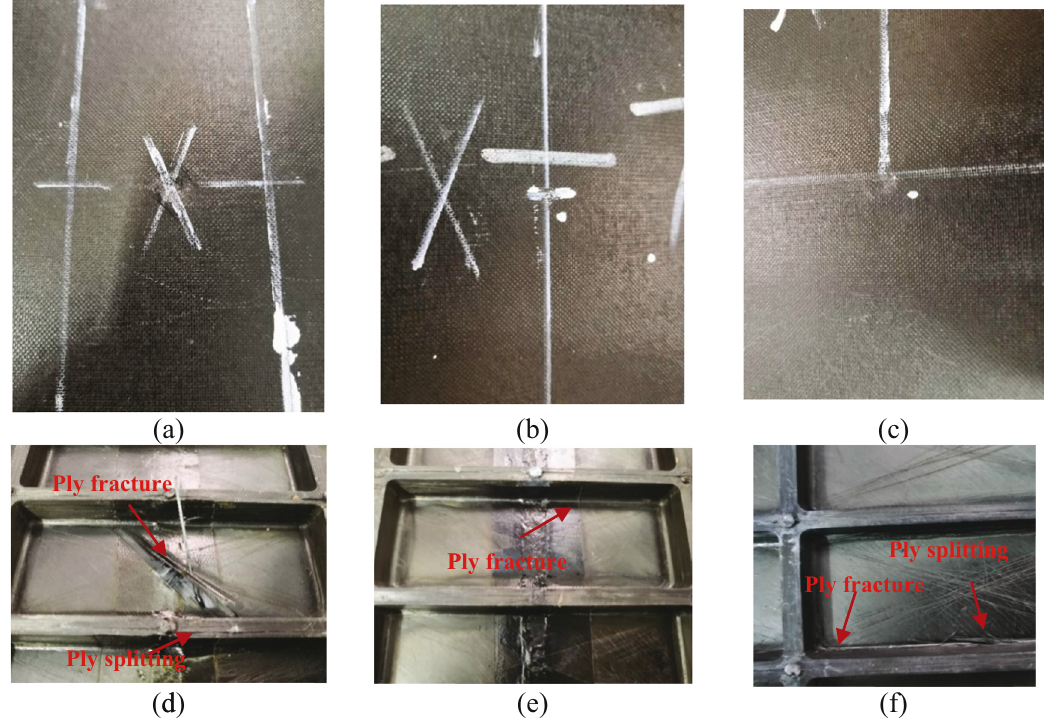
Figure 7: ( a and d ) External damage of #10 specimen; ( b and e ) external damage of #11 specimen; and ( c and f ) external damage of #12 specimen.